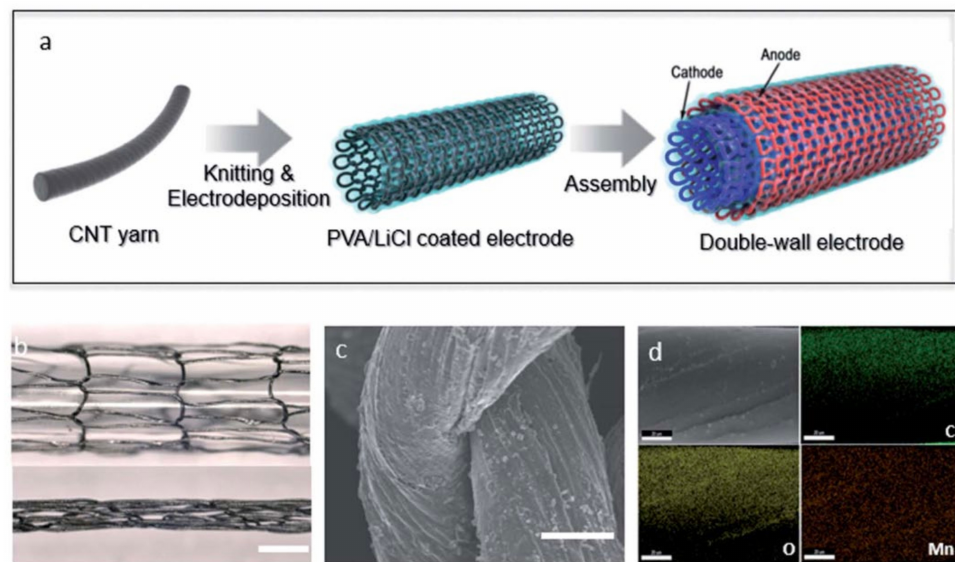
Figure 19. Schematic and images of knitted MnO 2 @CNT fiber SC. ( a ) Fabrication scheme of a double- walled knitted MnO 2 @CNT FSC. ( b ) Optical image of non-stretched ( ε = 0) and stretched ( ε = 100) knitted structures (scale bar: 1 mm). ( c ) SEM image of a knitted MnO 2 @CNTfiber supercapacitor (scale bar, 500 µ m, and 50 µ m). ( d ) EDX mapping images of knitted MnO 2 @CNTfiber supercapacitor (scale bar: 20 µ m). Reprinted with permission from [95].